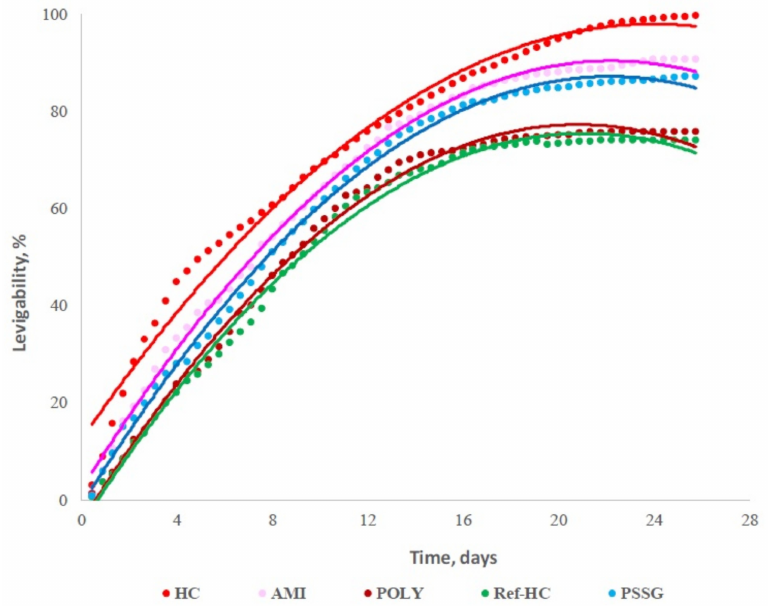
Figure 7. Oxidable nutrient release (organic and inorganic), in water for different collagen-leather- based biopolymers [77]; HC—collagen hydrolysate, Ref—HC—collagen hydrolysate with nutri- ents encapsulated as reference sample, PSSG—Ref—HC functionalized with P(SSNa—co—GMAx) copolymer, POLY—Ref—HC functionalized with polyacrylamide, AMI—Ref—HC functionalized with